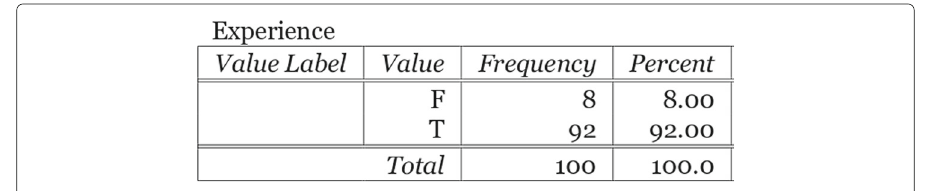
pre/post phases much closer in time. The scores obtained by non-CG students in the PSVT during the pre/post phases were analyzed with a paired t-test. The purpose of this case was to estimate the effect of repetition (when a student takes the test twice) on improving the PSVT score. In this case, the pre-test was conducted in the third week of the semester, and the post-test five weeks